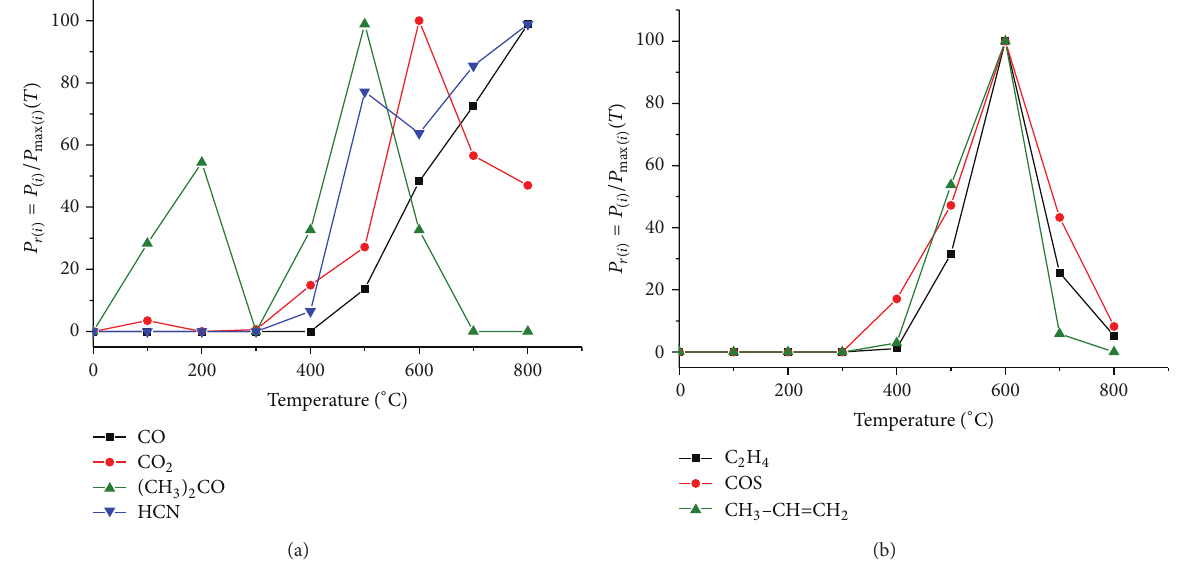
Figure 9: (a) Relative pressure values of CO, CO 2 , (CH 3 ) 2 CO, and HCN against temperature for South Africa coal. (b) Relative pressure values of C 2 H 4 , CH 3 –CH=CH 2 , and COS against temperature for South Africa coal.